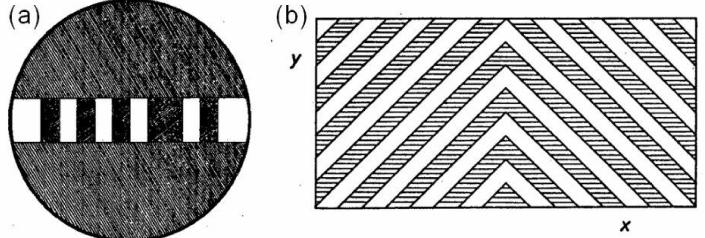
Fig. 1. Two slit systems for photoelectric observation with a meridian circle. Left: Str¨omgren 1925 and right: Høg 1960, the latter for two-dimensional measurement. In France it was called \une grille de H(cid:28)g" in the early